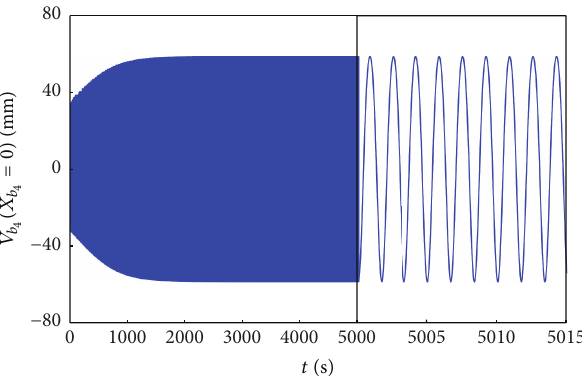
Figure 13: Time response of the midpoint of the deck beam; 𝑞 𝑟 (0) = 𝑁 = 11 . 0.1𝛿 1𝑟 and